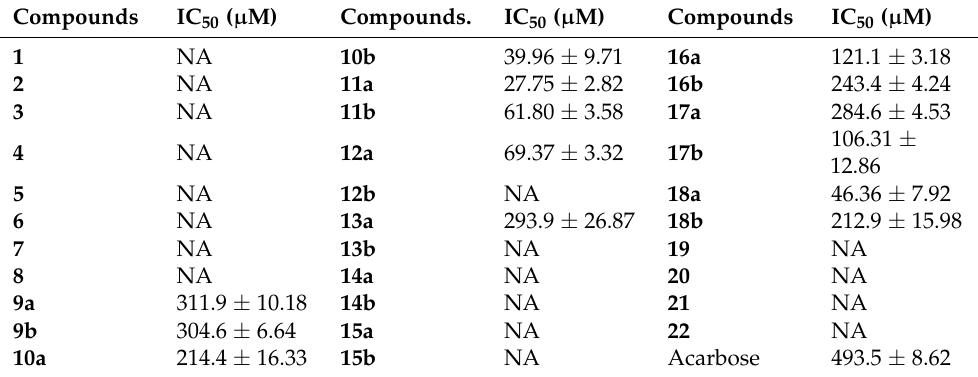
Table 2. α -Glucosidase inhibitory assay results for all the compounds a . Compounds IC 50 ( µ M)